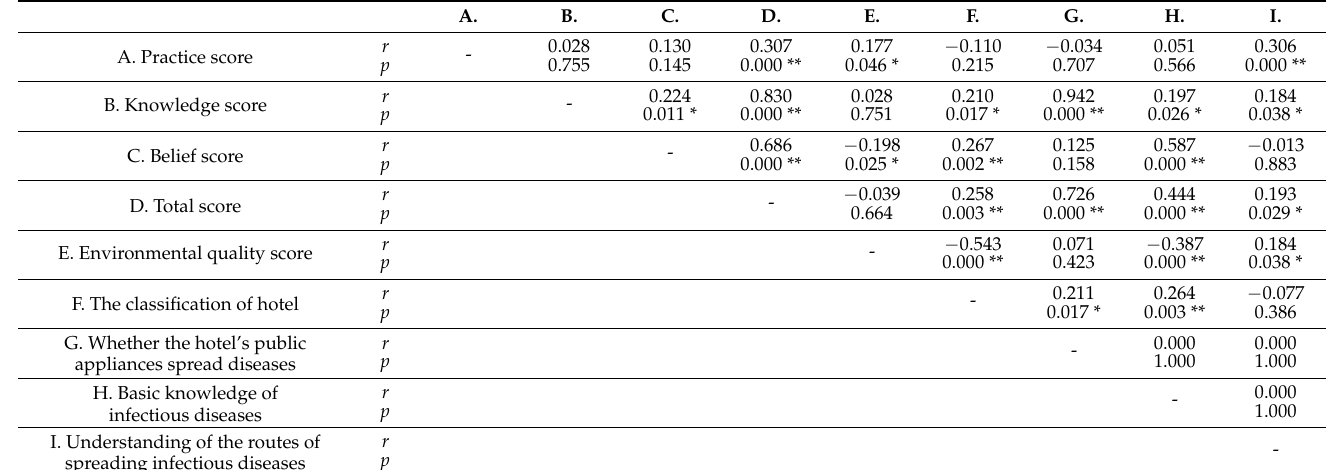
Table 3. Correlation between knowledge, beliefs, practices of practitioners, and environmental quality ( n =